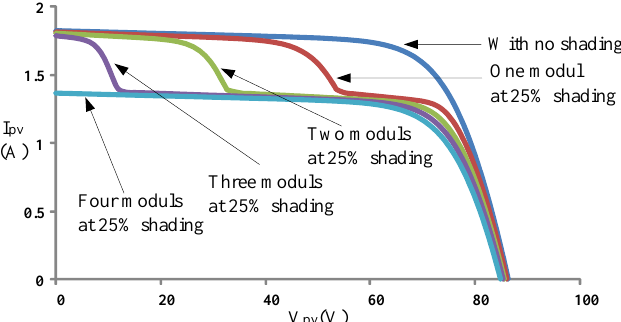
Figure 1. Current–voltage (I–V) curves of the 4-series 1-parallel array when different numbers of modules were at 25% shading.